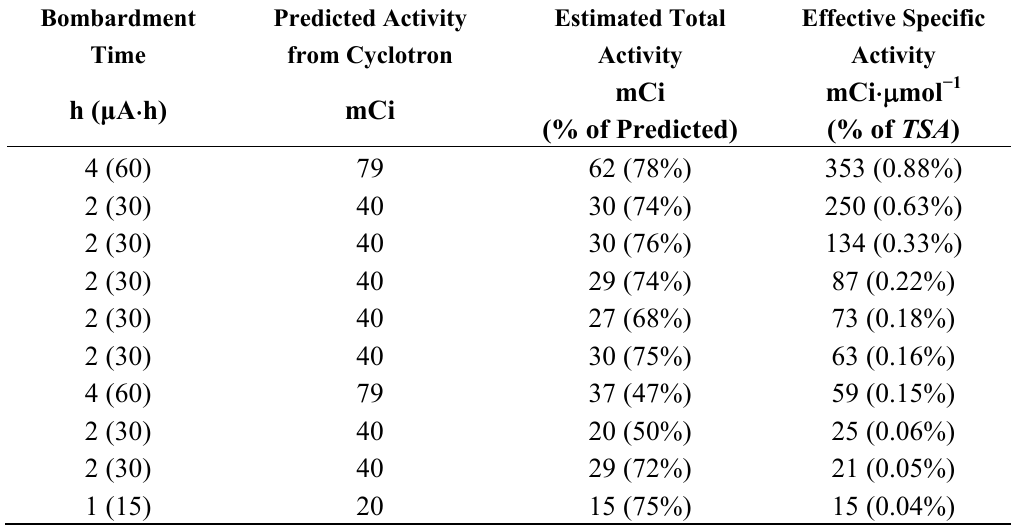
Table 3. Results from ten productions of 89 Zr selected for having the highest effective specific activities (sorted from highest to